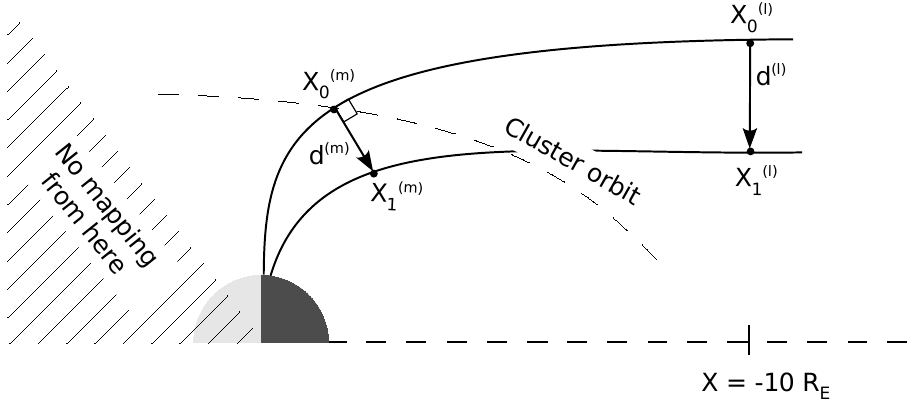
Fig. 2. Illustration of the mapping procedure. The vector d ( m ) , is along the convection velocity measured by EDI, and per definition perpendicular to the magnetic field at x ( m ) . The vector d ( m ) is projected along the field lines to the lobe at X=-10 R E . The mapped vector d ( l ) lies in the Y Z GSM plane. The convection velocity in the lobe at x ( l ) is then V ( l ) = V ( m ) ∗ d ( l ) /d ( m ) .